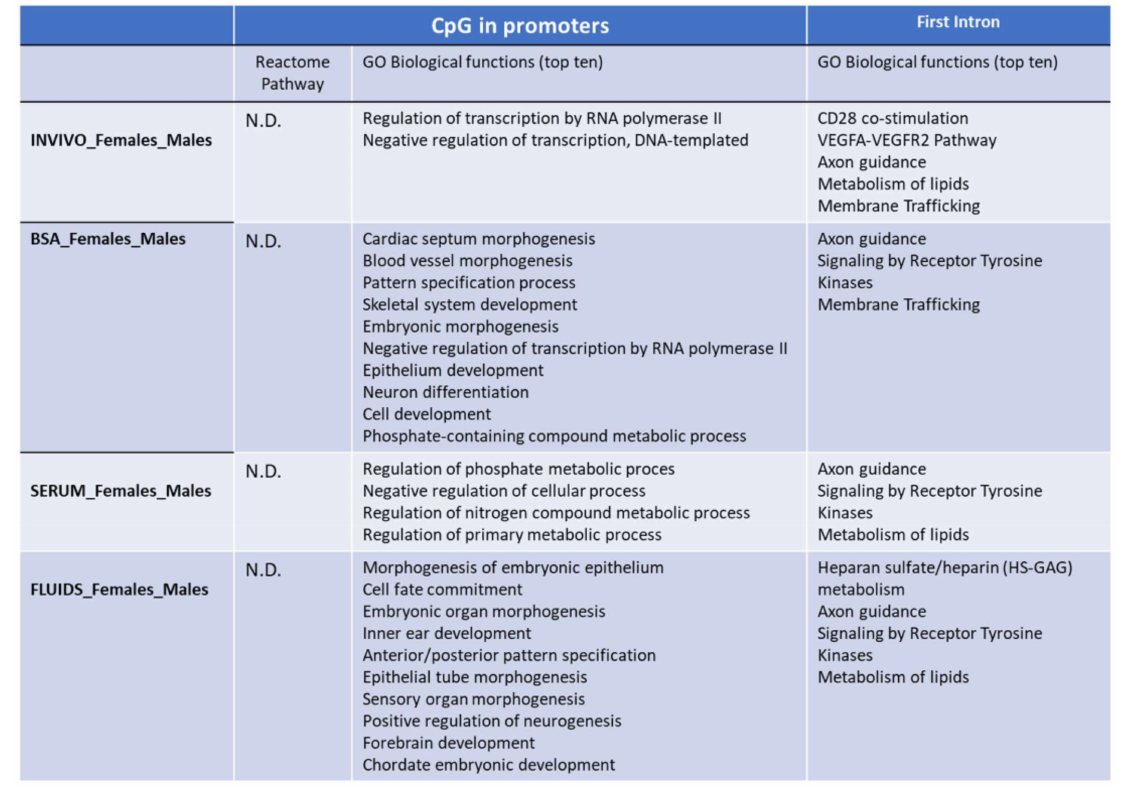
Figure 9. Functional annotation using PANTHER. GO biological functions and Panther pathways overrepresented in the CpG in promoters or FIRST introns with differential methylation between male and female blastocyst for each group. Fisher’s exact test using the Bonferroni correction for multiple testing was apply for statistical overrepresentation analysis. N.D: not